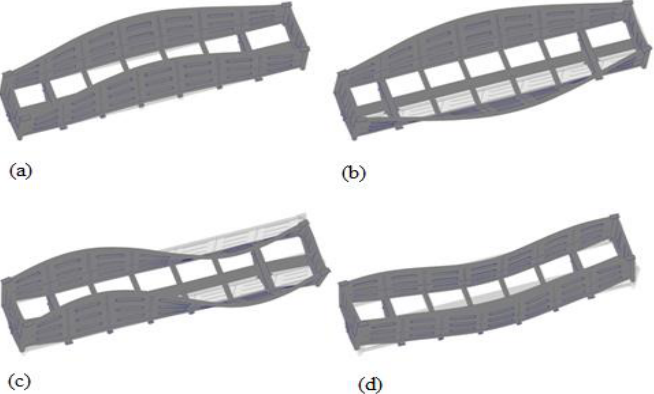
Figure 10. Oscillation modes in carrying structure of open wagon ( a ) 1st natural frequency; ( b ) 2nd natural frequency; ( c ) 3rd natural frequency; ( d ) 4th natural frequency. Table 1. Natural oscillation frequencies in carrying structure of the open wagon.